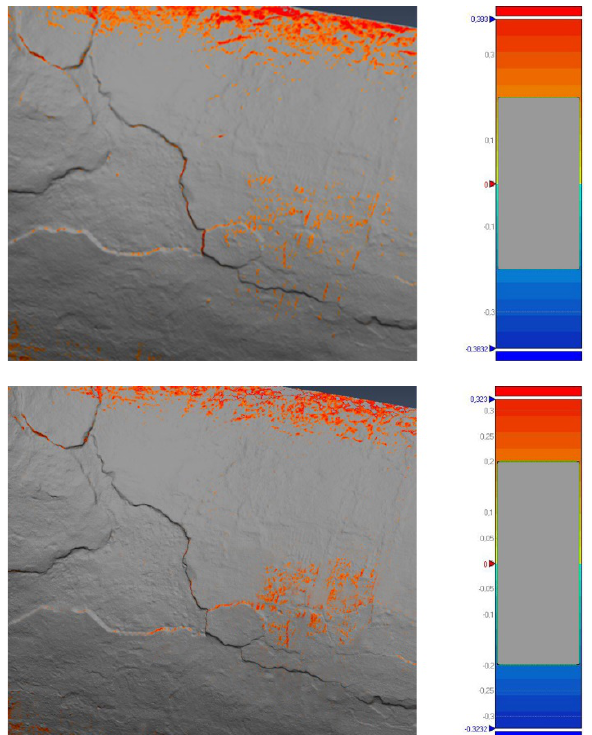
Figure 15. Up, the mesh distances between scanner model and the high resolution mesh from depth maps. Down, the mesh distances between scanner model and the ultra-high resolution mesh from depth maps.